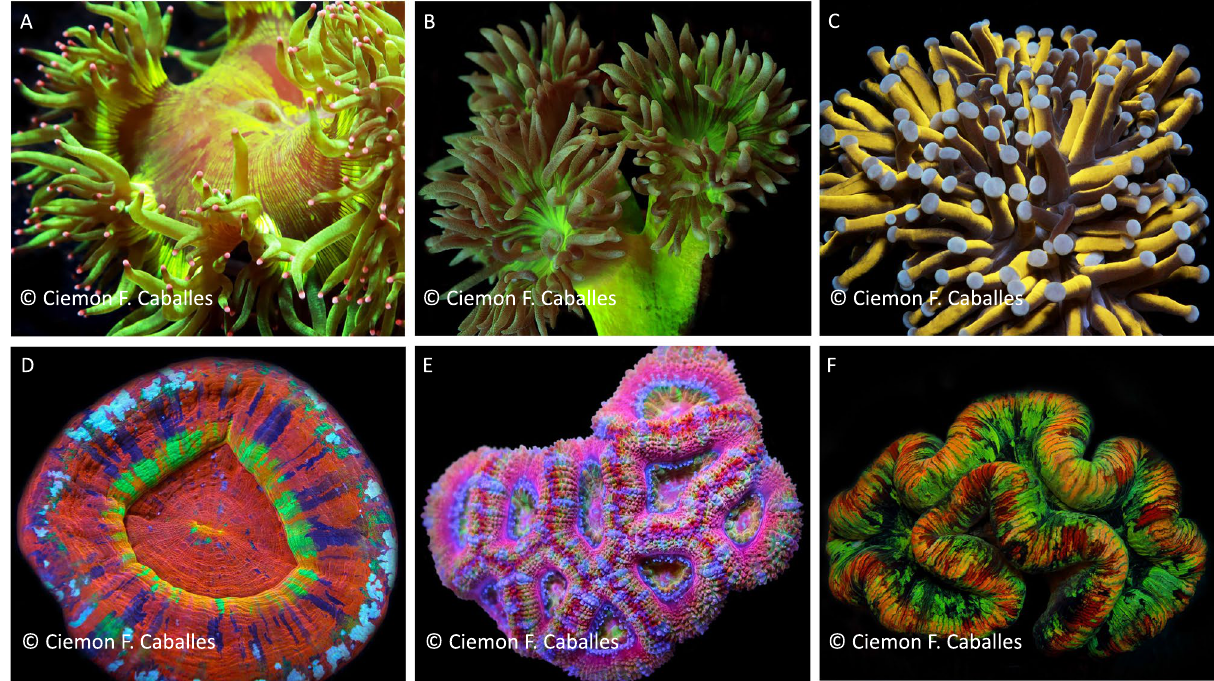
Figure 3. LPS (Large Polyp Stony) corals targeted for commercial collection used in the current study, namely; ( A ) Catalaphyllia jardinei, ( B ) Duncanopsammia axifuga ( C ) Euphyllia glabrescens ( D ) Homophyllia cf. australis , ( E ) Micromussa lordhowensis , ( F ) Trachyphyllia geoffroyi